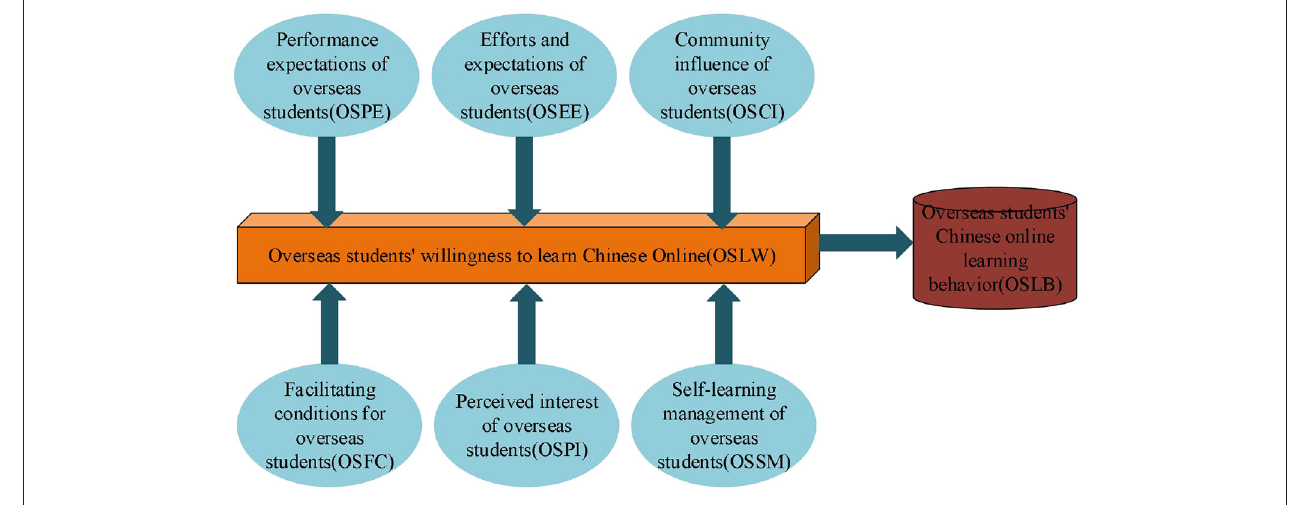
FIGURE 1 | OCL-oriented OS WTL factor model.